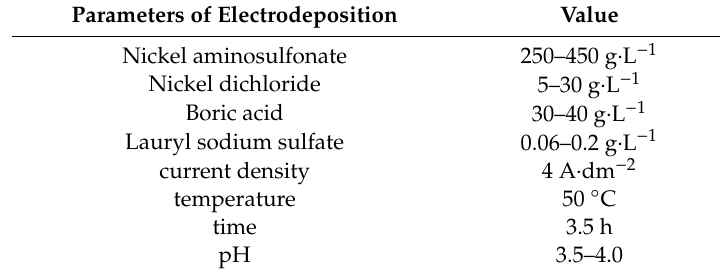
Table 2. Electrodeposition parameters.